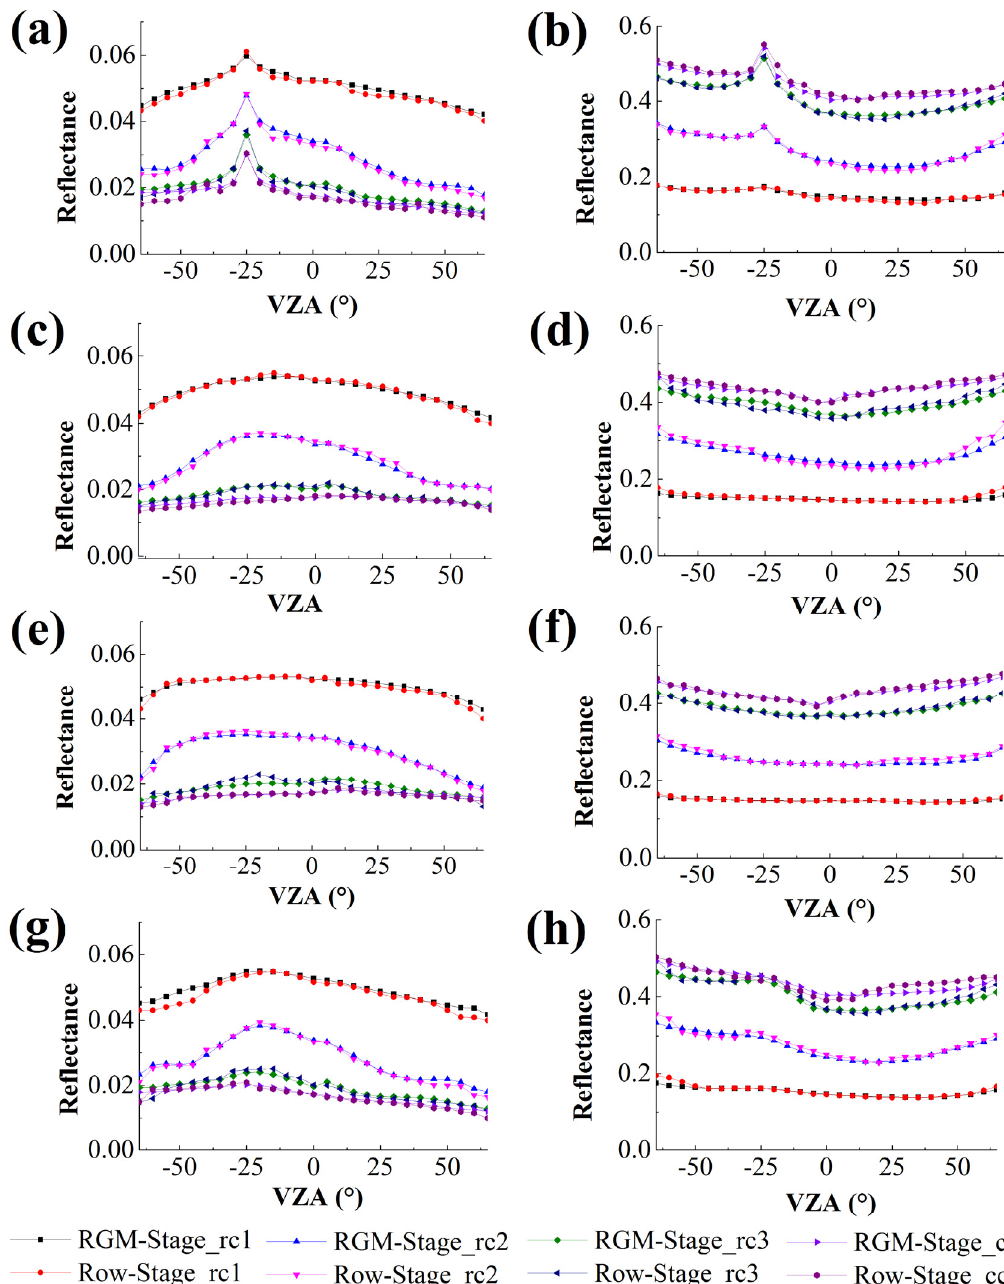
Figure 6. The distribution of the sum of the reflectance in the red band and near-infrared (NIR) band simulated by the RGM model and the row model in four viewing modes: ( a ) principal plane (PP) mode in the red band, ( b ) principal plane (PP) mode in the NIR band, ( c ) orthogonal plane (OP) mode in the red band, ( d ) orthogonal plane (OP) mode in the NIR band, ( e ) along-row plane (AR) mode in the red band, ( f ) along-row plane (AR) mode in the NIR band, ( g ) orthogonal row plane (OR) mode in the red band, and ( h ) orthogonal row plane (OR) mode in the NIR band. Here, VZA is the viewing zenith angle.